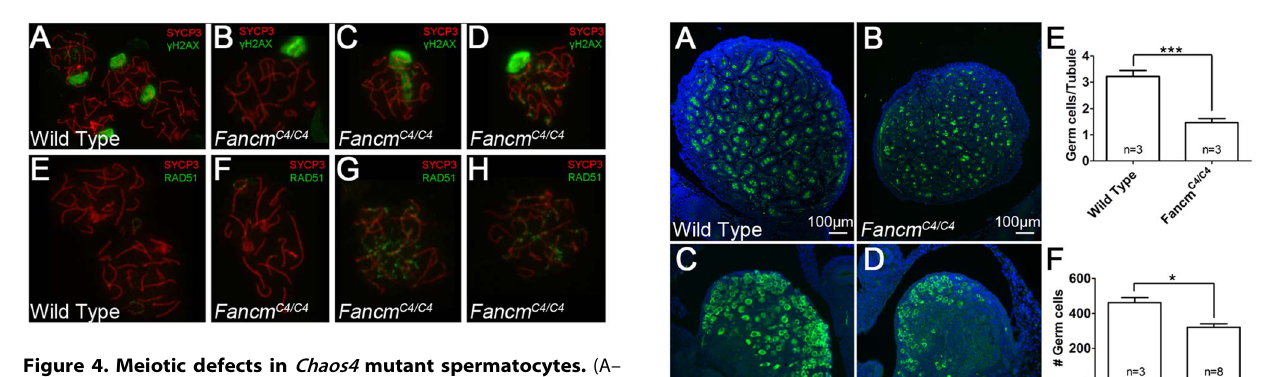
Figure 4. Meiotic defects in Chaos4 mutant spermatocytes. (A– H) Shown are surface spread meiotic chromosomes from the indicated genotypes of males. Antibodies used for immunolabeling are as indicated with color coding. SYCP3 is a synaptonemal complex protein marking chromosome cores. The large domains of c H2AX staining in A,B and D correspond to the XY body. In panel C, there is an extended region of XY body-like staining over autosomes, a pattern typically called a ‘‘pseudo sex body’’ and usually marks asynapsed autosomes. All nuclei are in the pachytene stage of meiosis.